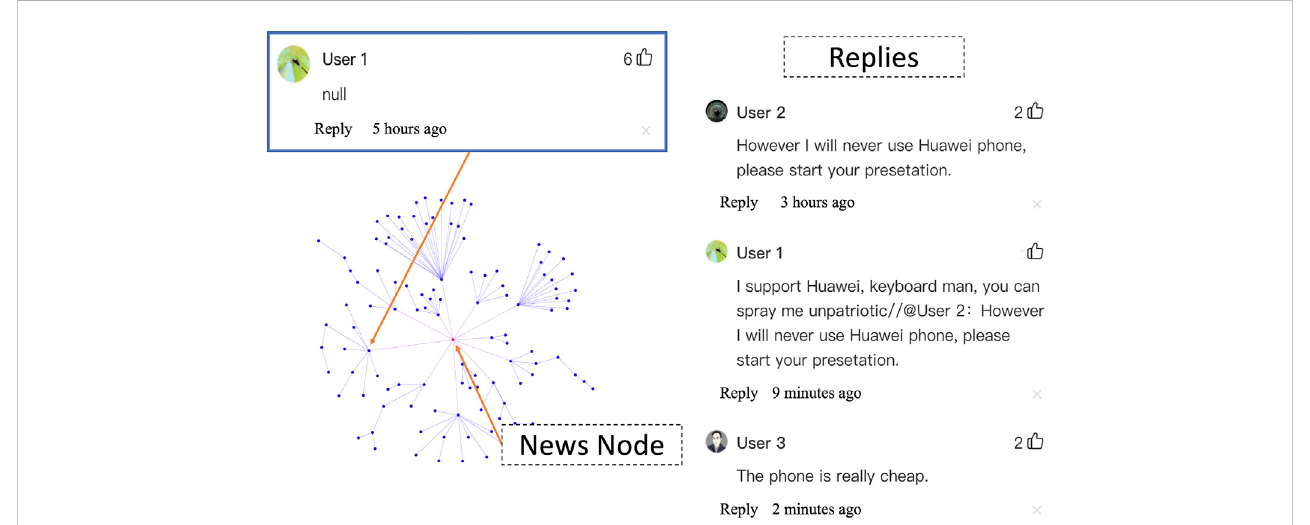
FIGURE 2 Controversial comment tree under one news article of Huawei , and one of the comments has been deleted.